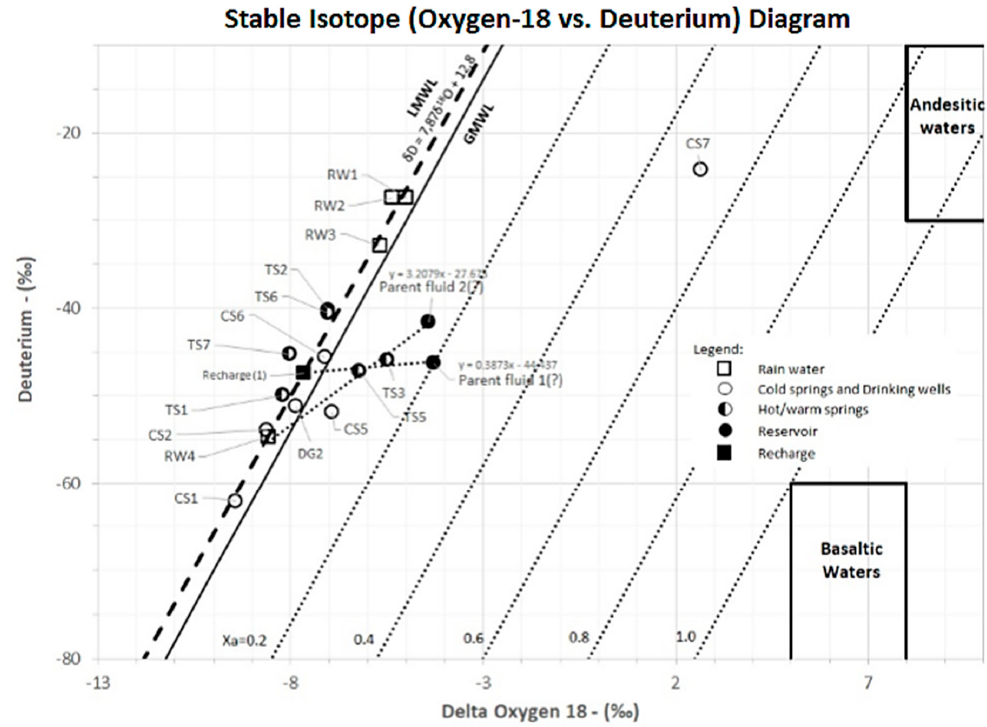
Figure 9. The relationship between δ 18 O and δ 2 H in cold and thermal waters toward the local meteoric water line (LMWL) of the Tampomas area. The LMWL line from the research area is relatively lighter than the global meteoric water line (GMWL) [33]. Full circles are an interpretation of the reservoir fluid from Equation (2).